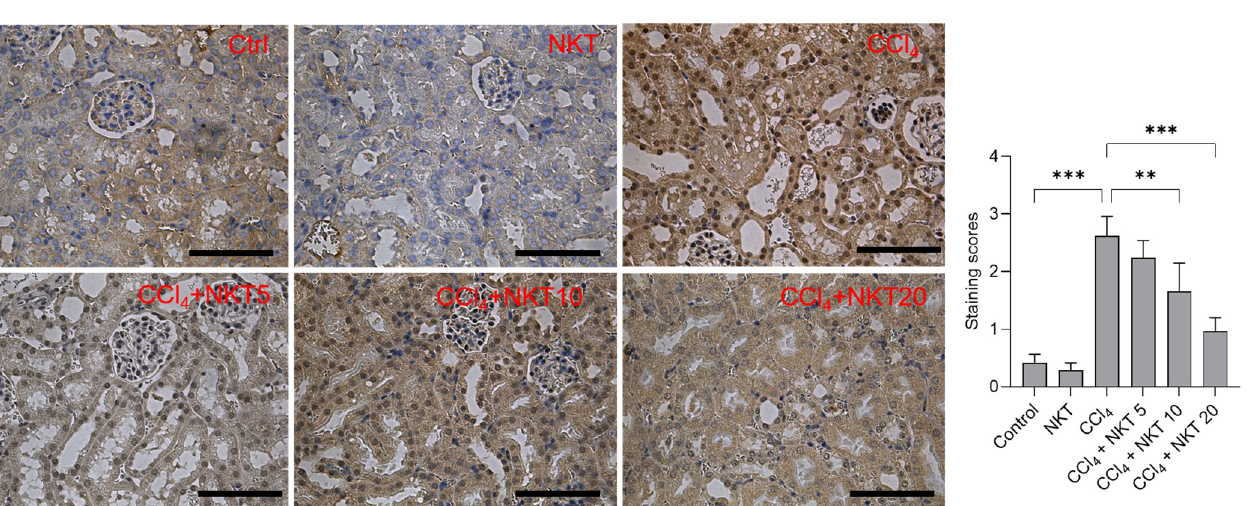
Figure 8. Immunohistochemical images of NOX4 protein in the kidney tissue. After treatment, the expression of NOX4 protein in the kidney tissues was measured by using an immunohistochemical staining method. The representative images ( on the left ) and semi-quantitative analysis ( on the right ) were shown. ** p < 0.01 and *** p < 0.001. Bar = 50 μ m.